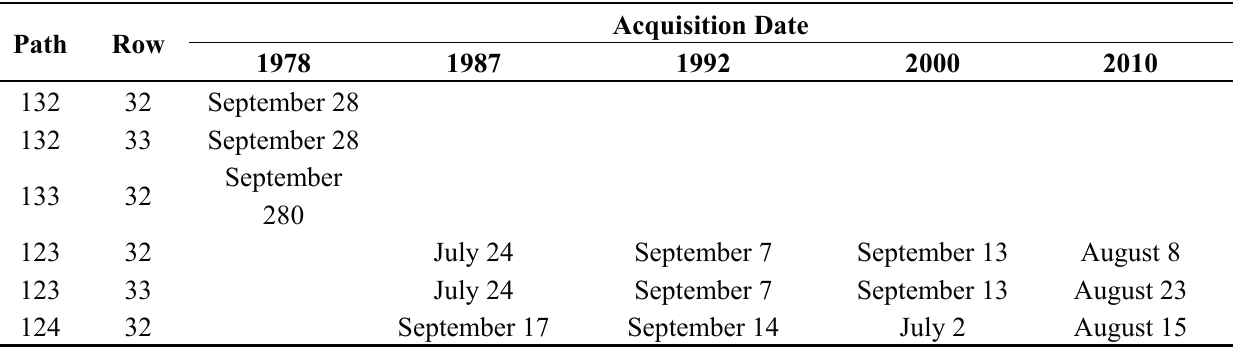
Table 1. List of Landsat images used for LULC classification in this study.